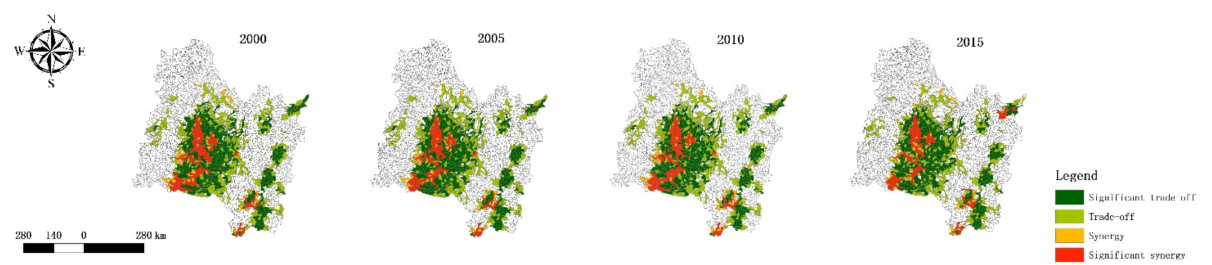
Figure 17. The synergy/trade-off relationship between crop production and soil